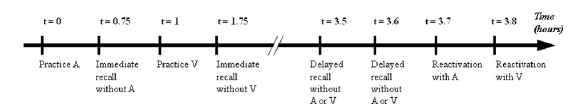
FIGURE 2 | Tests of the experimental protocol : practice, immediate recall, differed recall and reactivation for auditory sequence (A) and visual sequence (V). Immediate retention corresponds to process between practice and immediate recall. Differed retention corresponds to process between immediate recall and differed recall (without stimuli). Reactivation corresponds to process between differed recall (without stimuli) and reactivation (with the reintroduction of the stimuli).